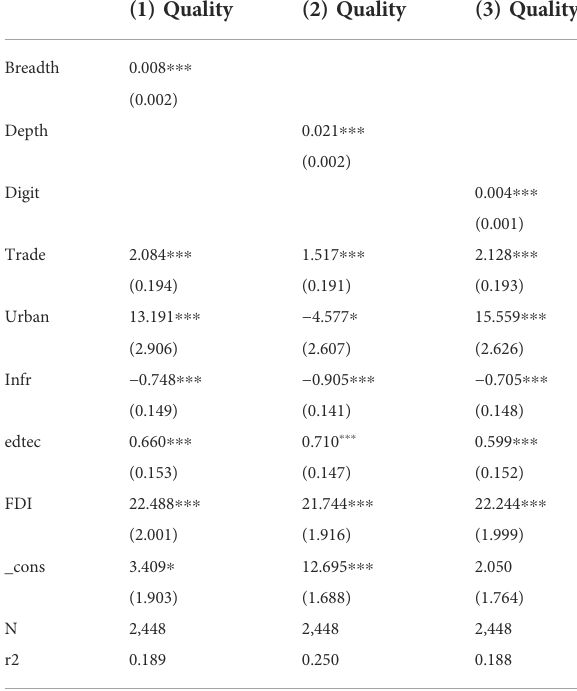
TABLE 4 Results of the digital fi nance subdimension